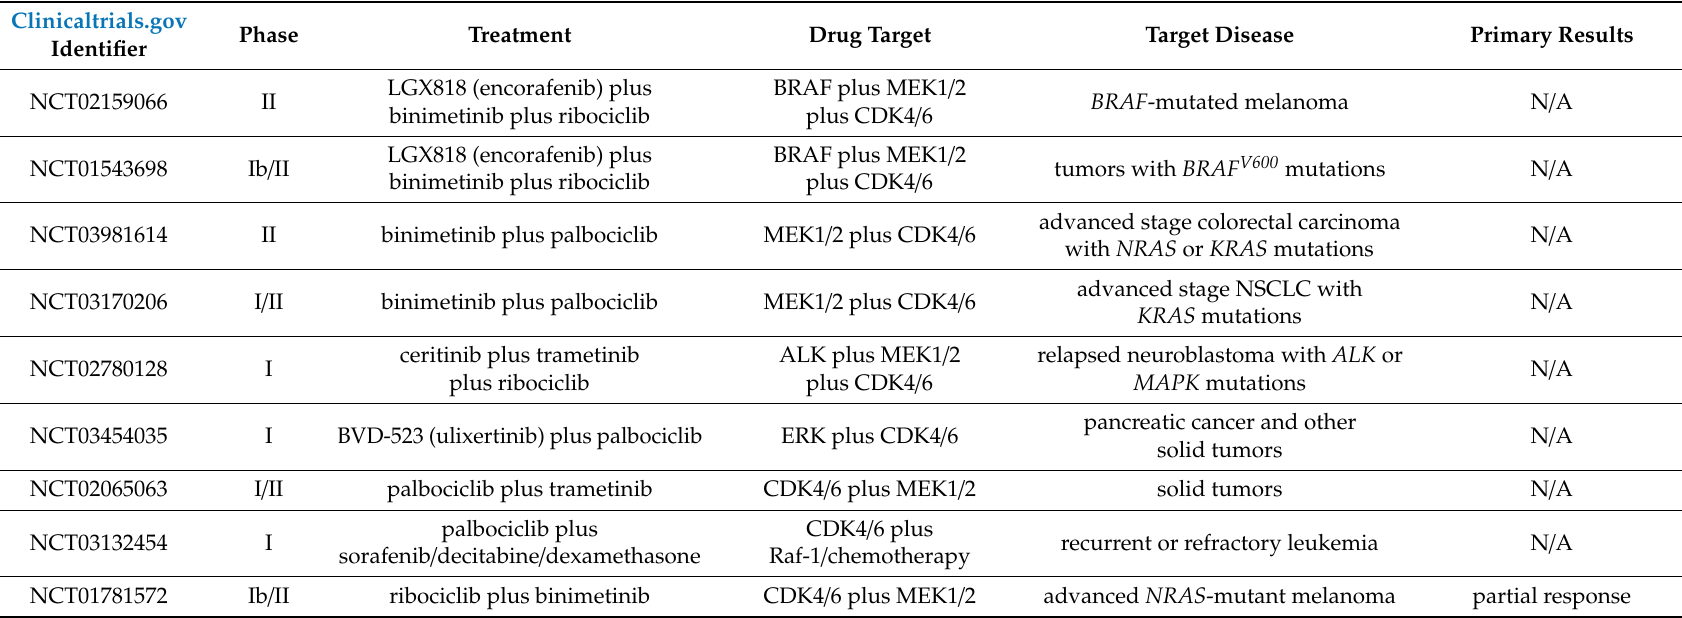
Table 4. Overview of ongoing clinical trials with combined CDK4 / 6 and MAPK inhibitor